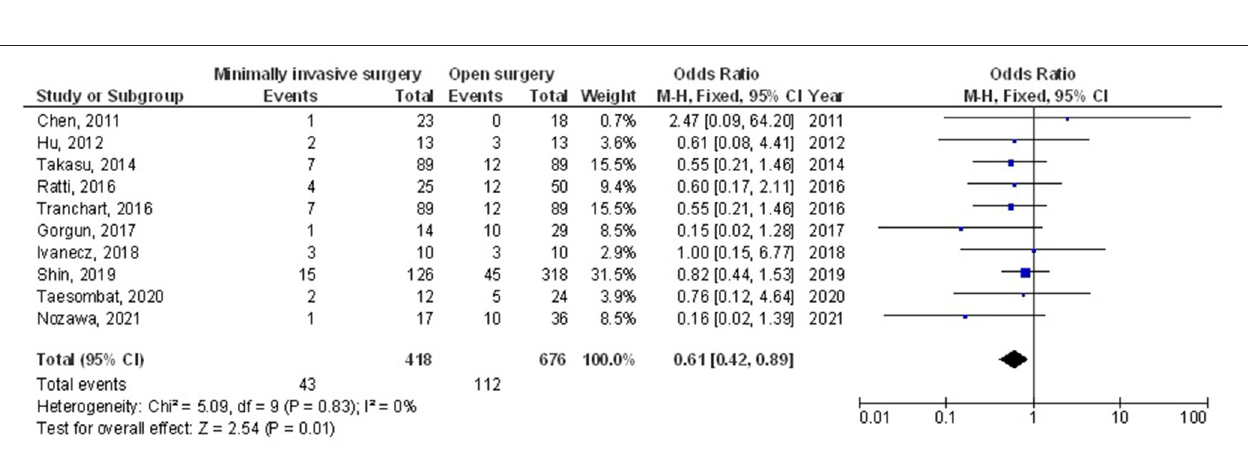
FIGURE 6 | Forest plot of the effect of minimally invasive surgery compared to open surgery on overall complications in subjects with colorectal cancer and synchronous colorectal liver metastases.